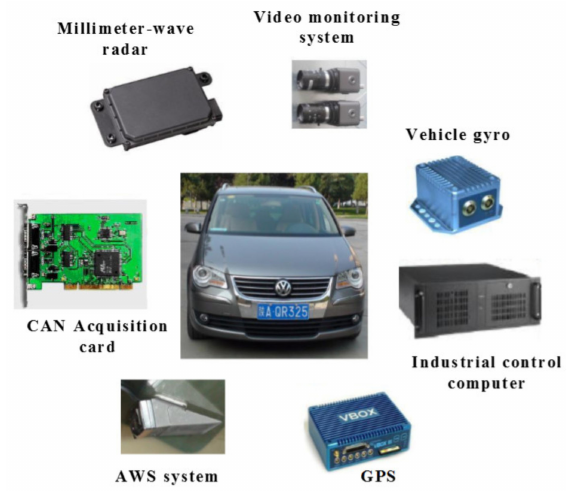
Figure 4. Driving scenarios in ( a ) Huzhou city and ( b ) Xi’an city.